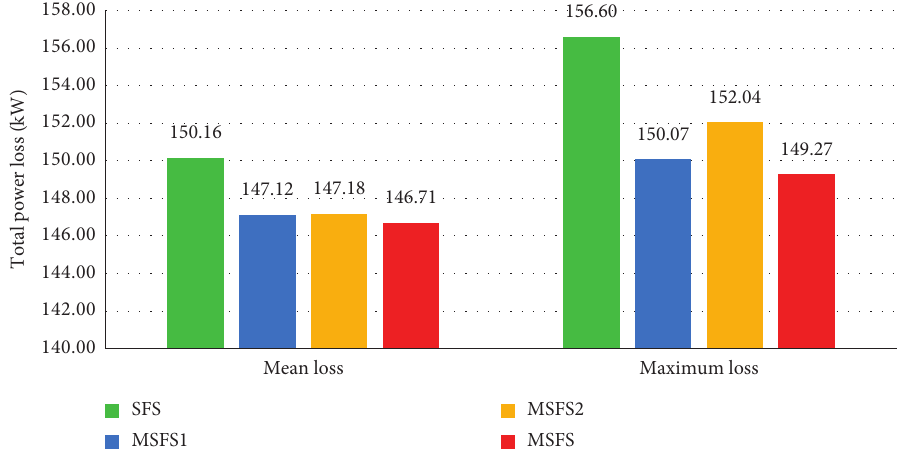
Figure 12: Mean and maximum power loss of 50 trial runs obtained by SFS methods for case 1 of the 69-bus and MSF2 and much higher than MSFS. MSFS not only has by 0.03, 1.55, and 2.21 kW, respectively. The outstanding very smaller oscillations but also reaches many solutions performance of MSFS over SFS can be clearly seen through with the same quality as the best solution. The manner can Figure 21. The fluctuations of SFS are higher than MSFS1